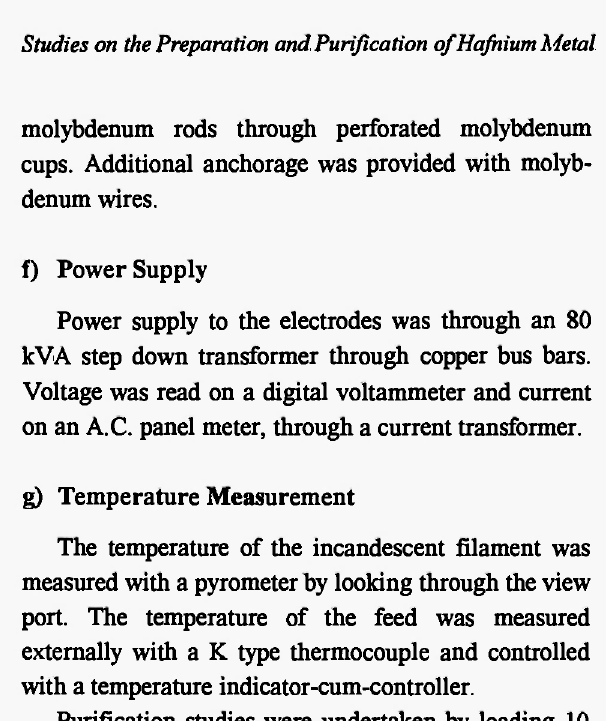
Fig. 5: Iodide refining